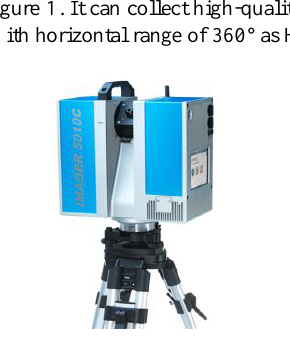
Figure 1. Terrestrial laser scanner(Z+F IMAGER 5010C)